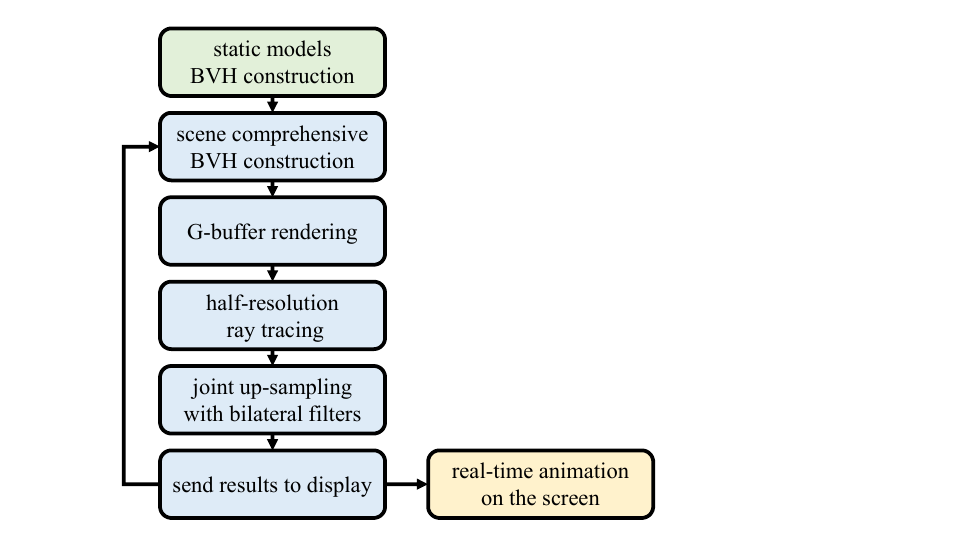
Figure 5. Overview of our ray tracing